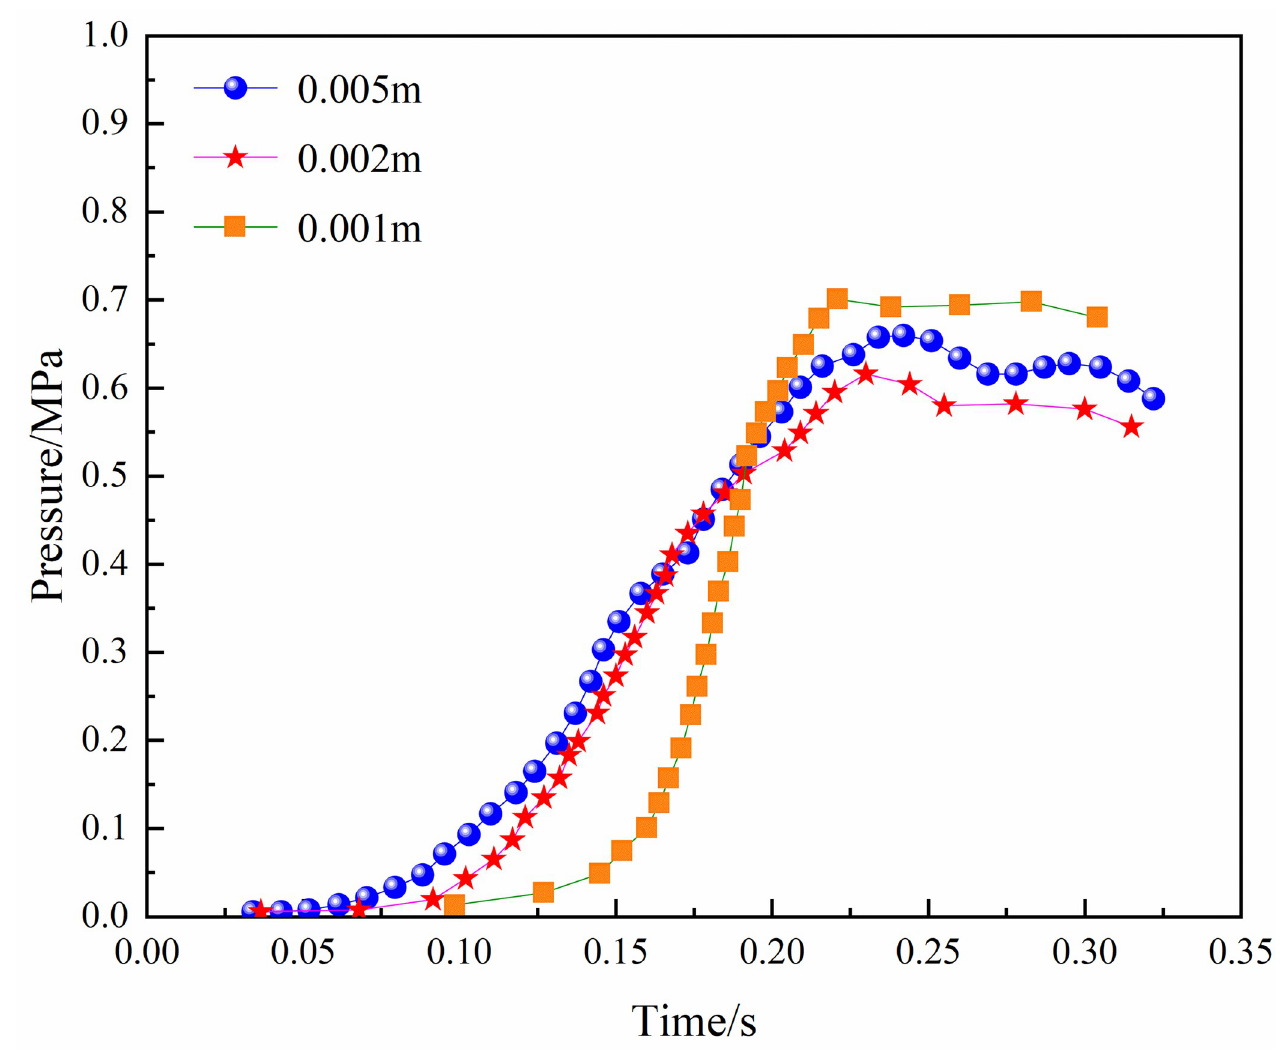
Fig 8. Pressure-time curves under different mesh